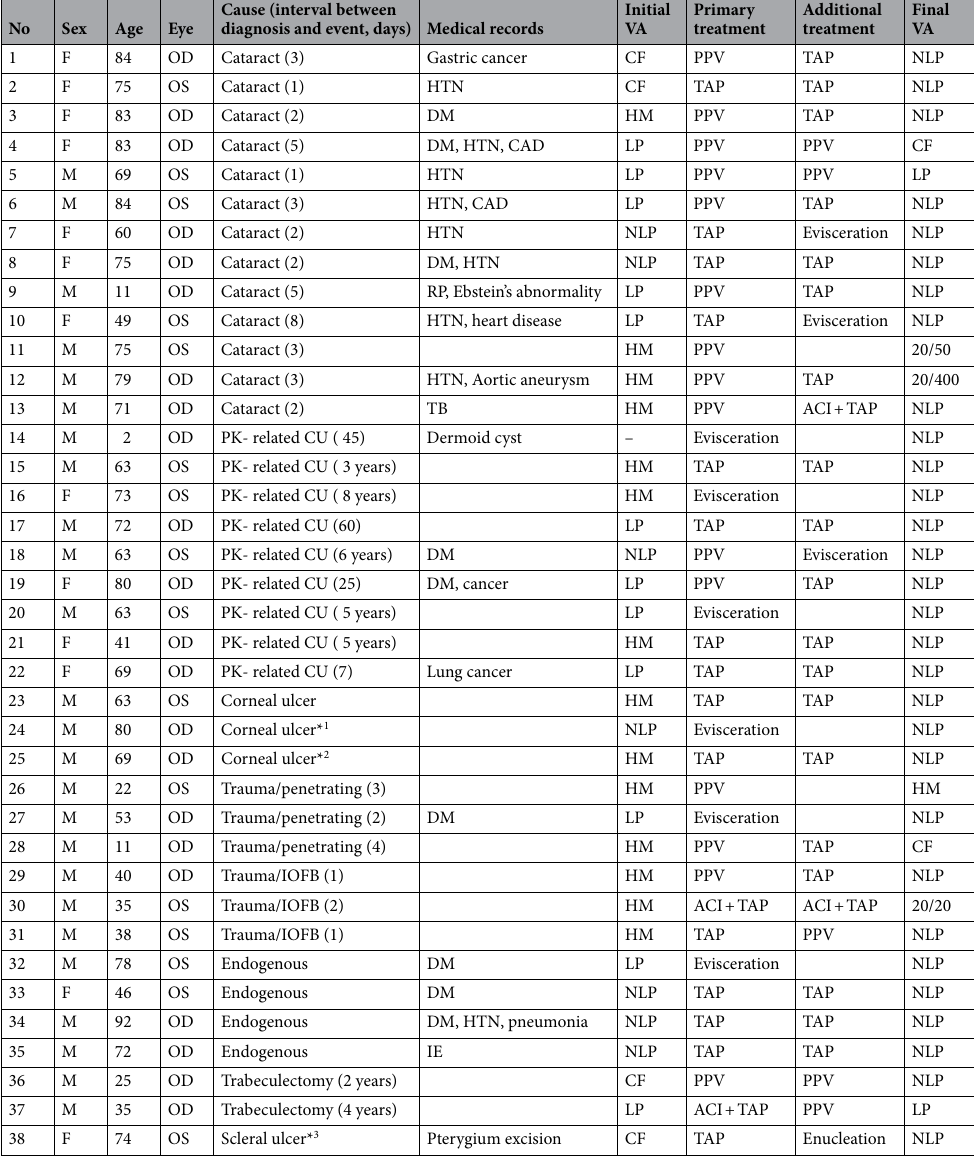
Table 2. Management and visual outcomes in Streptococcus pneumoniae endophthalmitis. ACI anterior chamber irrigation; CAD coronary arterial disease; CF counting fingers; CU corneal ulcer; DM diabetes mellitus; HM hand motions; HTN hypertension; IE infective endocarditis; IOFB intraocular foreign body; LP light perception; NLP no light perception; PK penetrating keratoplasty; PPV pars plana vitrectomy; TAP tap and injection. *Associated organisms: Proteus mirabilis 1 , Serratia marcescens 2 , and Klebsiella oxytoca 3